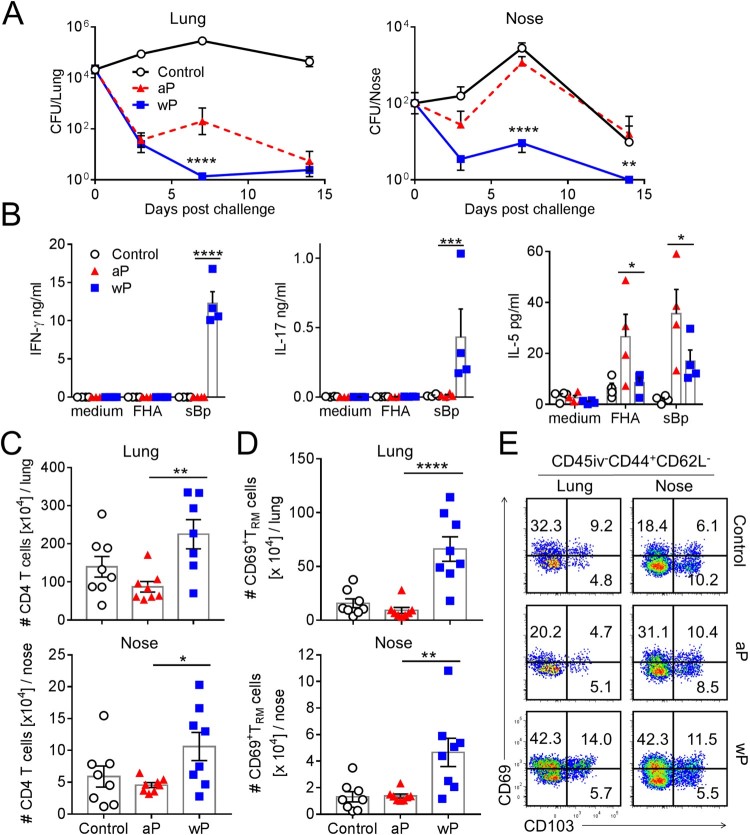
Immunization with a wP vaccine promotes formation of CD69+CD4+ TRM cells in the nose and lungs and prevents nasal colonization. C57BL/6 mice were immunized with 1/50 human dose of aP (Boostrix) or wP (NIBSC) twice (-6 and -2 weeks) before aerosol challenge with B. pertussis. (a) CFUs in the lungs and nose were enumerated at indicated time points. Lung and nose CFU counts (mean ± SEM n = 8 mice per group per time-point in two independent experiments). **p < .01, ****p < .0001 versus aP by two-way ANOVA with the Tukey’s post-test. (b) On the day of but prior to B. pertussis challenge spleen cells were stimulated with FHA or sonicated B. pertussis (sBp) or medium only and IFN-γ, IL-17 and IL-5 concentrations in supernatants were quantified by ELISA after 3 days of culture. Results shown are mean ± SEM (n = 4 mice in triplicate). *p < .05, ***p < .001, ****p < .0001 versus aP by one-way ANOVA with the Tukey’s post-test, only significant differences between experimental groups are indicated. (c–e) Seven days post challenge, mice were injected i.v. with anti-CD45 Ab 10 min prior to euthanasia to discriminate circulating from tissue-resident leukocytes by flow cytometry. (c) Total number of CD4 T cells in the lungs (upper graph) and nasal cavity (lower graph). (d) Total number of CD45iv–CD44+CD62L–CD69+CD4+ TRM cells in the lungs and nasal cavity. Results (c and d) are mean ± SEM (n = 8 mice in two independent experiments) *p < .05, **p < .01, ****p < .0001 versus aP by one-way ANOVA with the Tukey’s post-test, only significant differences between experimental groups are indicated. (e) Representative plots for expression of CD69 and CD103 on CD45iv–CD44+CD62L–CD4+ T cells.